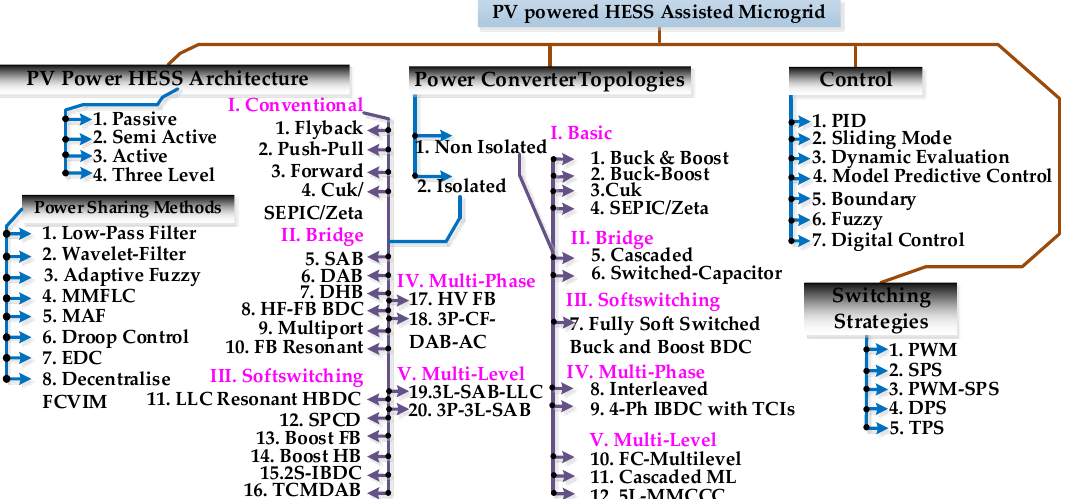
Figure 3. Classification of PV-powered HESS-Assisted Microgrid.